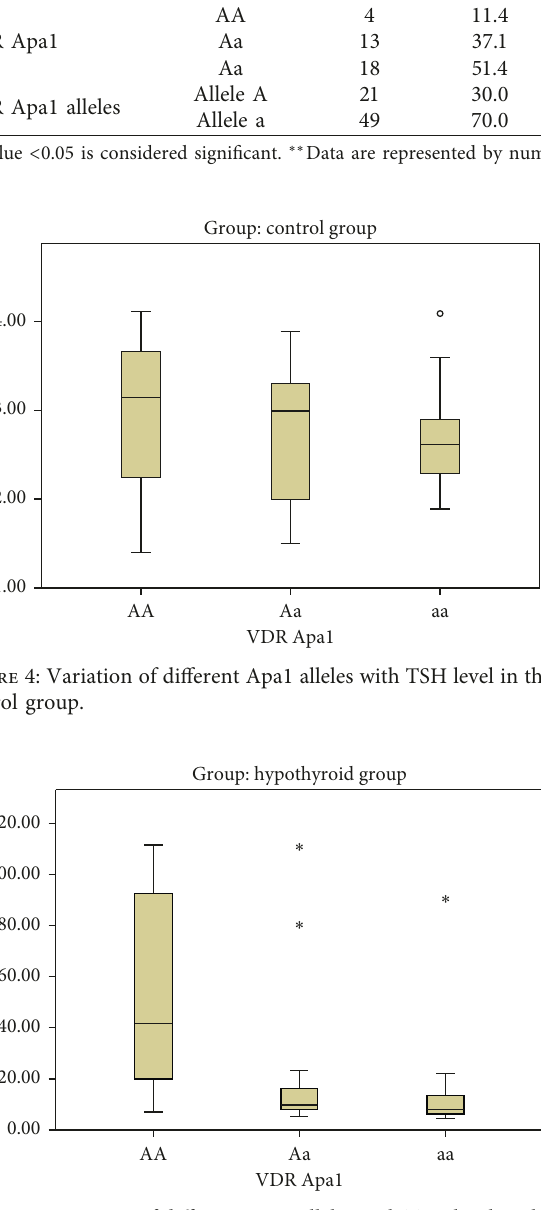
Figure 5: Variation of different Apa1 alleles with TSH level in the hypothyroid